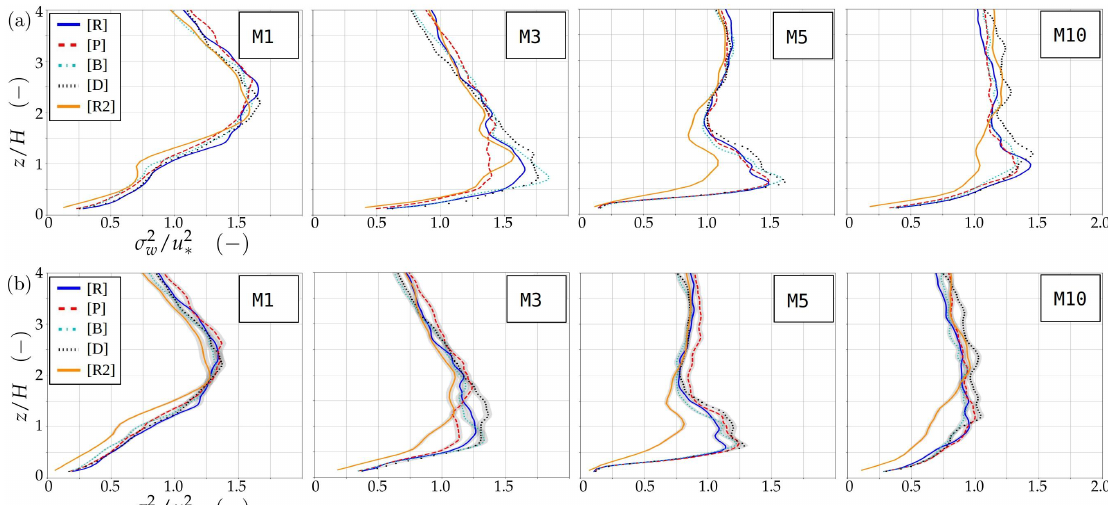
Figure 16. A juxtaposition of original ( a ) and filtered ( b ) dimensionless vertical velocity variance profiles at selected measurement